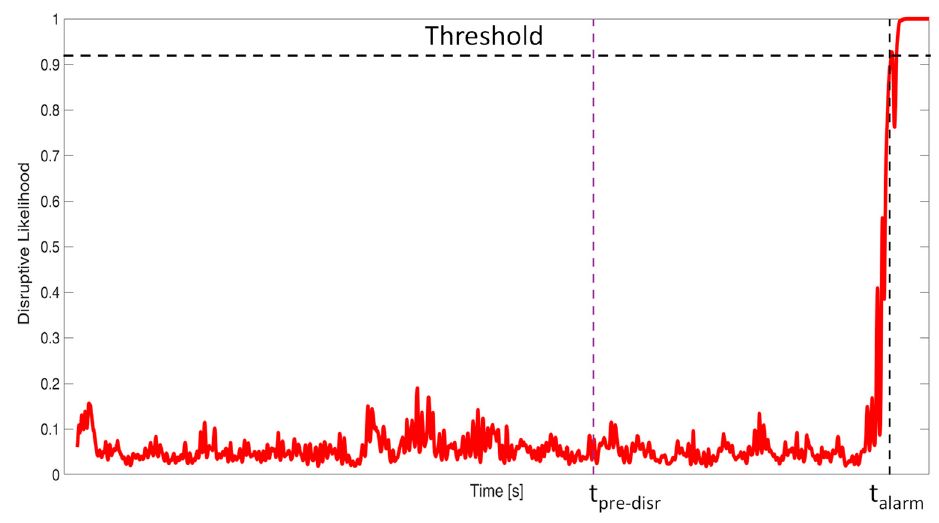
Figure 2. Disruptive likelihood evolutions in a disrupted discharge.